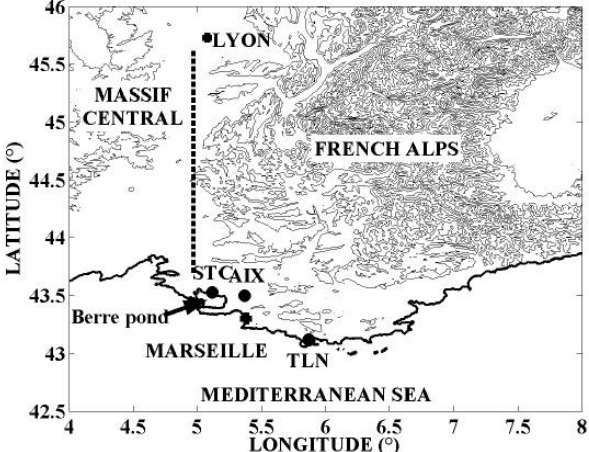
Fig. 2. Area in southern France targeted by our Mistral study. The UHF wind profiler sites, St-Chamas (STC), Aix-les-Milles (AIX) and Toulon (TLN), are indicated. The lower contour line, for the mountainous areas, is at 500m of altitude. The dotted line schemat- ically indicates the Rhˆone-valley axis. The distances between STC and AIX, and between STC and TLN, are 25km and 90km, respec-